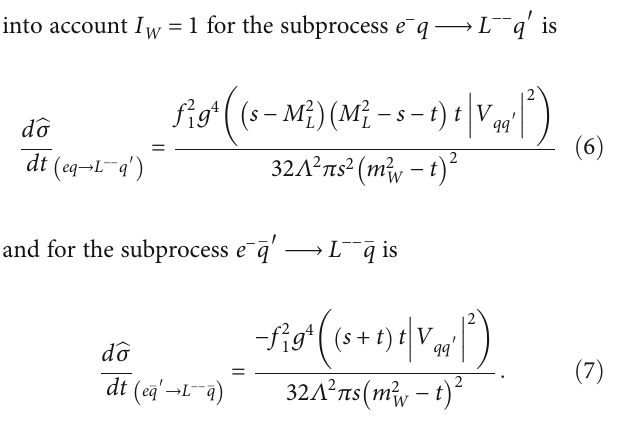
= 1 after the discovery W